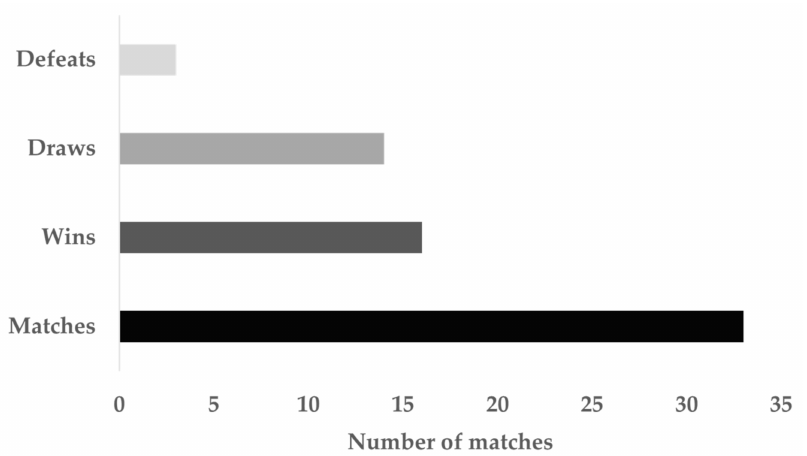
Figure 1. The number of matches evaluated and their division according to their results during the full